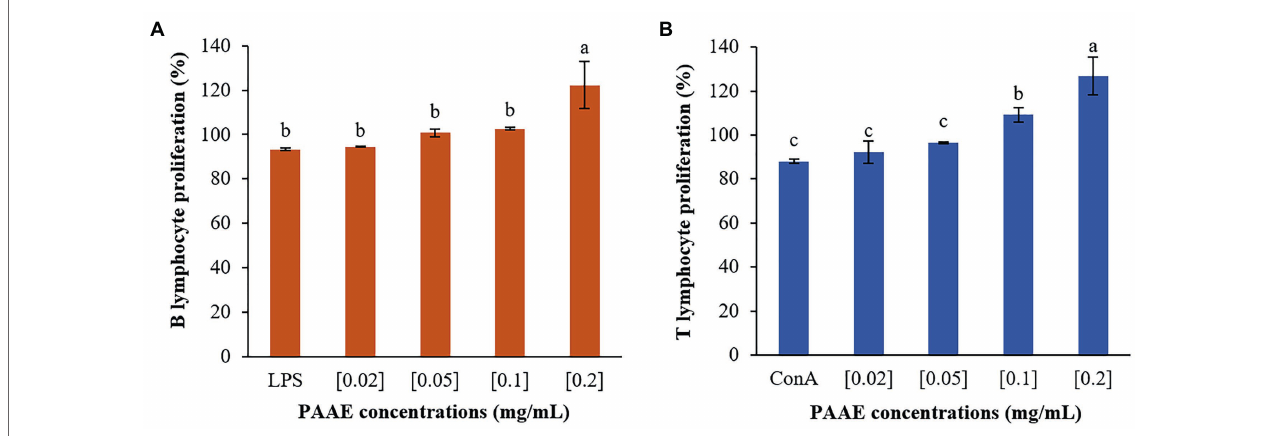
FIGURE 11 | The high-potential PAAEs stimulated B lymphocytes (A) and T lymphocytes (B) proliferation. The lymphocytes were derived from Wistar Hannover GALAS rats’ spleen cells. Positive controls include lipopolysaccharide (LPS) and concanavalin A (ConA). The results were expressed as mean with SD of three replications. The letters above the bars represent a statistically significant difference ( p <